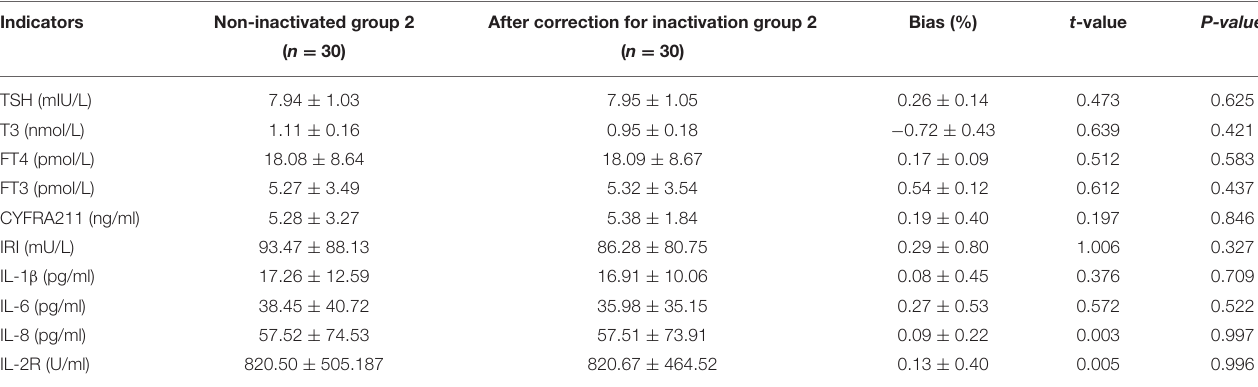
TABLE 4 | Comparison of corrected values and true values of some test items ( ¯ x ± s). Indicators